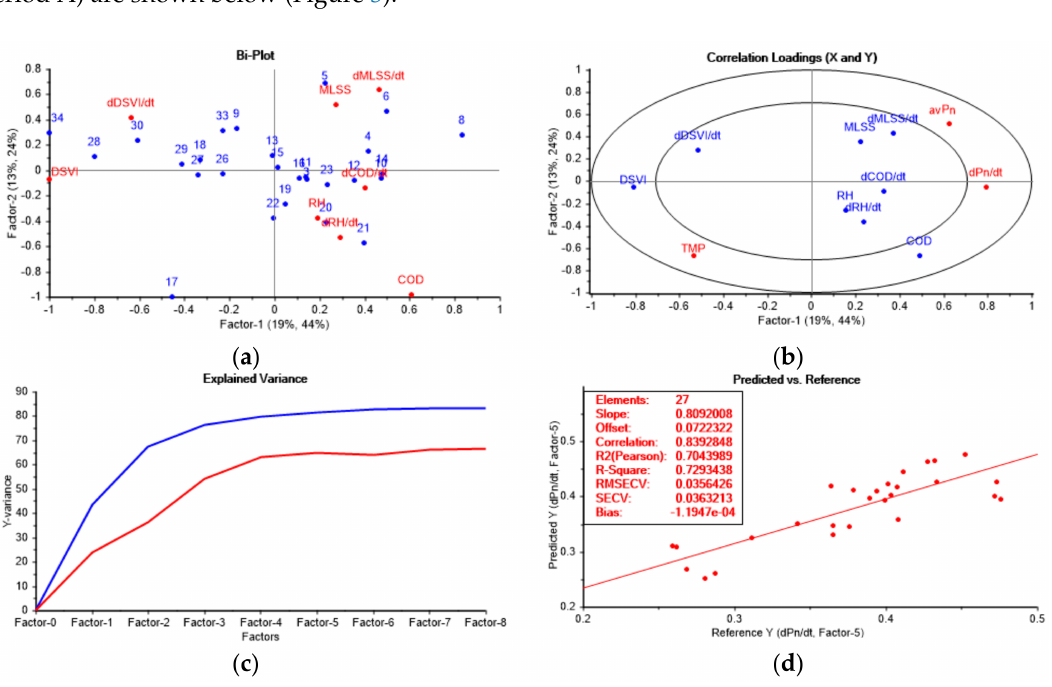
Figure 3. Results of PLS of the data from the period A of the filtration performance monitoring: ( a ) Bi-plot; ( b ) loadings plot; ( c ) explained variance plot; ( d ) fouling intensity prediction